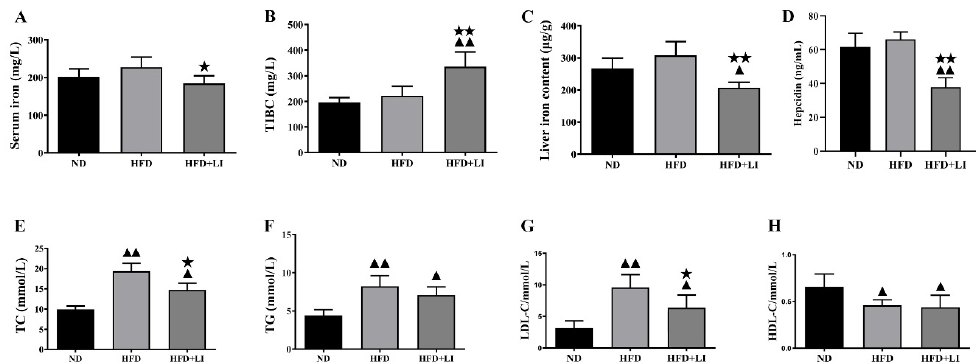
Figure 4. Iron parameters and lipid profiles in HFD + LI-fed ApoE KO mice. ( A – D ) Serum iron, serum total iron-binding capacity (TIBC), liver iron content and serum hepcidin were measured in each group (n = 6), and presented as the mean ± SD. Samples were pooled from three independent experiments. ( E – H ) Serum TC, TG, LDL-C, and HDL-C levels were determined in each group (n = 6), and presented as the mean ± SD. Samples were pooled from three independent experiments. ▲ p < 0.05 vs. ND; ▲▲ p < 0.01 vs. ND; ★ p < 0.05 vs. HFD; ★★ p < 0.01 vs. HFD. ND: normal diet-fed ApoE KO mice, HFD: high fat diet-fed ApoE KO mice, HFD + LI: high fat diet without iron supplementation-fed ApoE KO